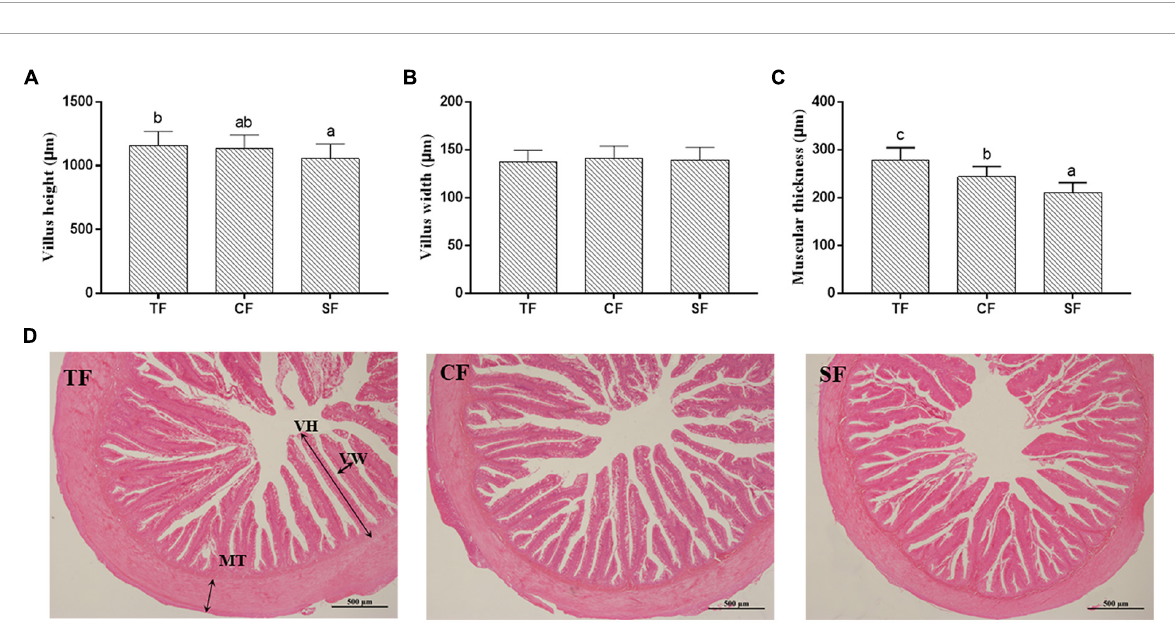
Table 1 ). The main differential metabolites were organic acids and derivatives (59 types), lipids and lipid-like molecules (35 types) according to Class classification. They were mainly